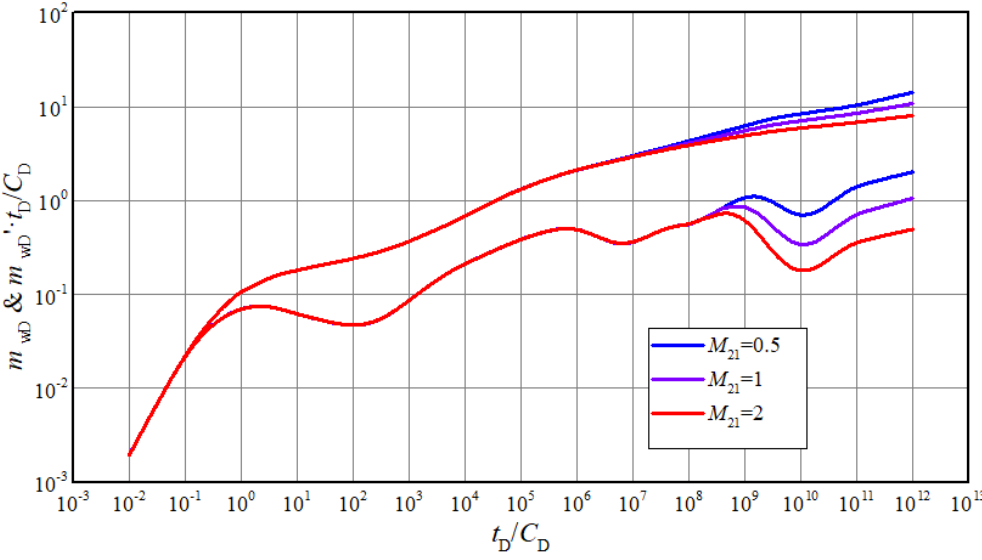
Figure 7. The effect of mobility ratio on transient pseudo-pressure and derivative curves.